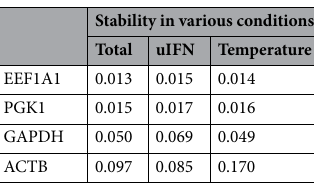
Table 3. Stability analysis of reference gene candidates based on estimated expression variations by